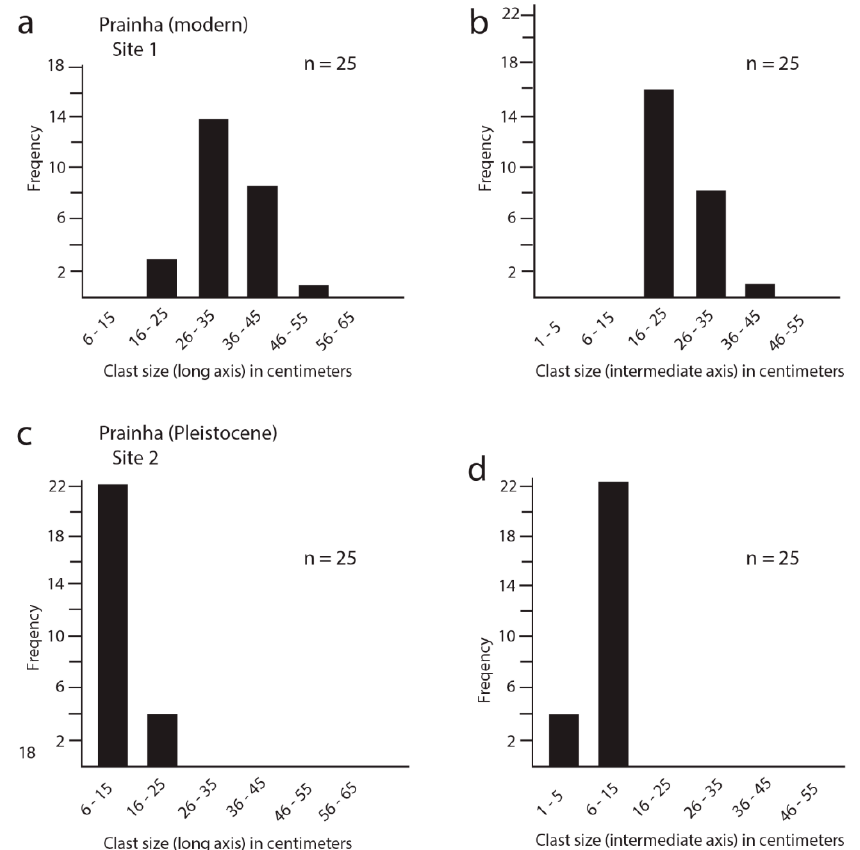
Figure 5. Bar graphs used to appraise variations in the long and intermediate axes on basalt clasts from modern and Pleistocene CBDs at Prainha; ( a ) Long-axis length from clasts in the modern CBD; ( b ) Intermediate-axis length from clasts in the modern CBD; ( c ) Long-axis length from clasts in the Pleistocene CBD; ( d ) Intermediate-axis length from clasts in the Pleistocene CBD.